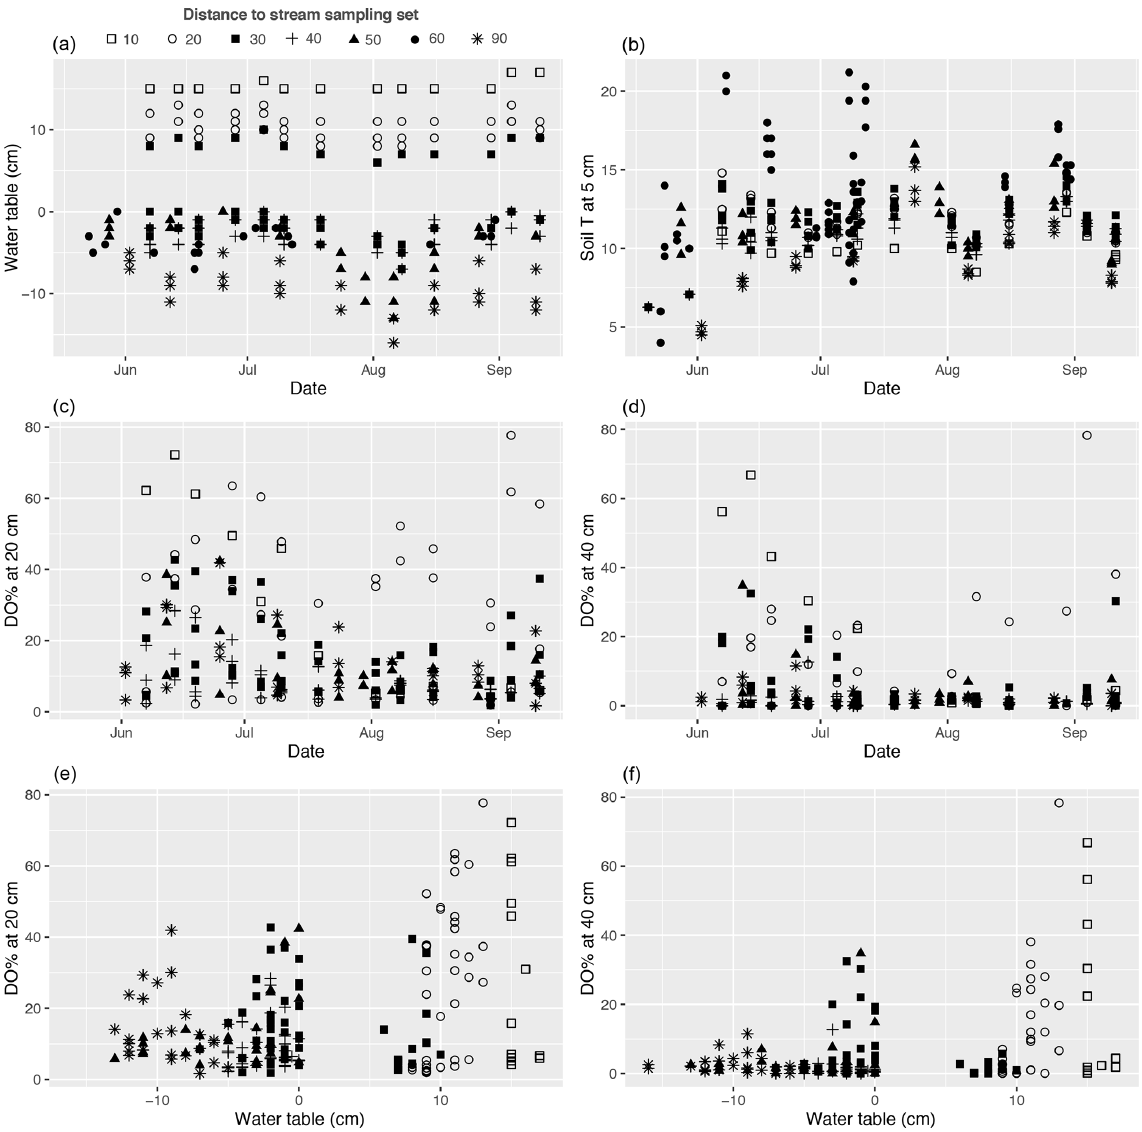
Figure A4. (a, b) Temporal variations in the water table, soil temperature ( T ) at 5cm below the peat surface, and (c, d) dissolved oxygen concentration (DO%) at 20 and 40cm below the surface during the 2019 growing season at each methane (CH 4 ) flux sample plot. (e, f) DO% at 20 and 40cm plotted against water table. Plots in the same set are labelled using the same